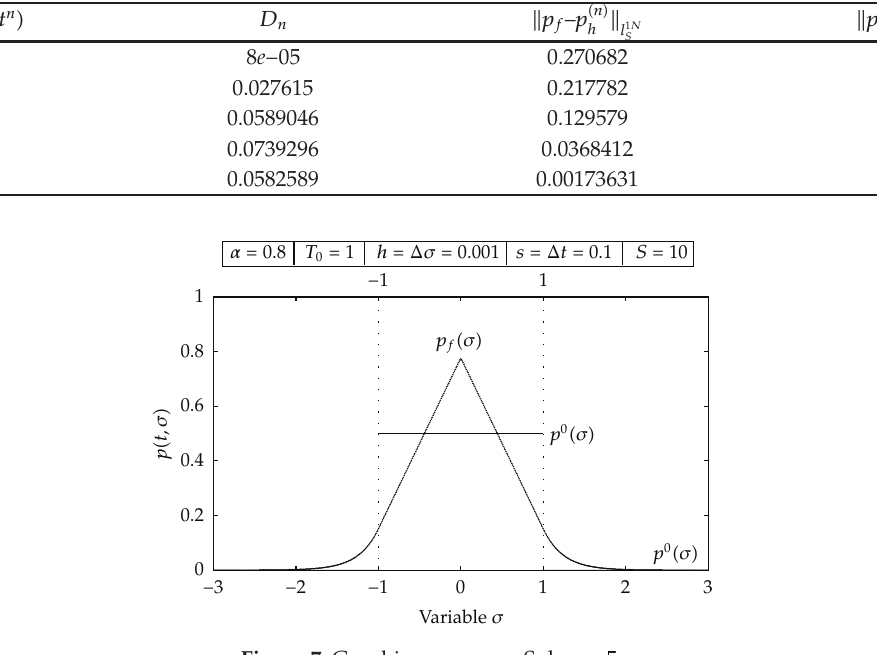
Figure 7: Graphics sequence: Subcase